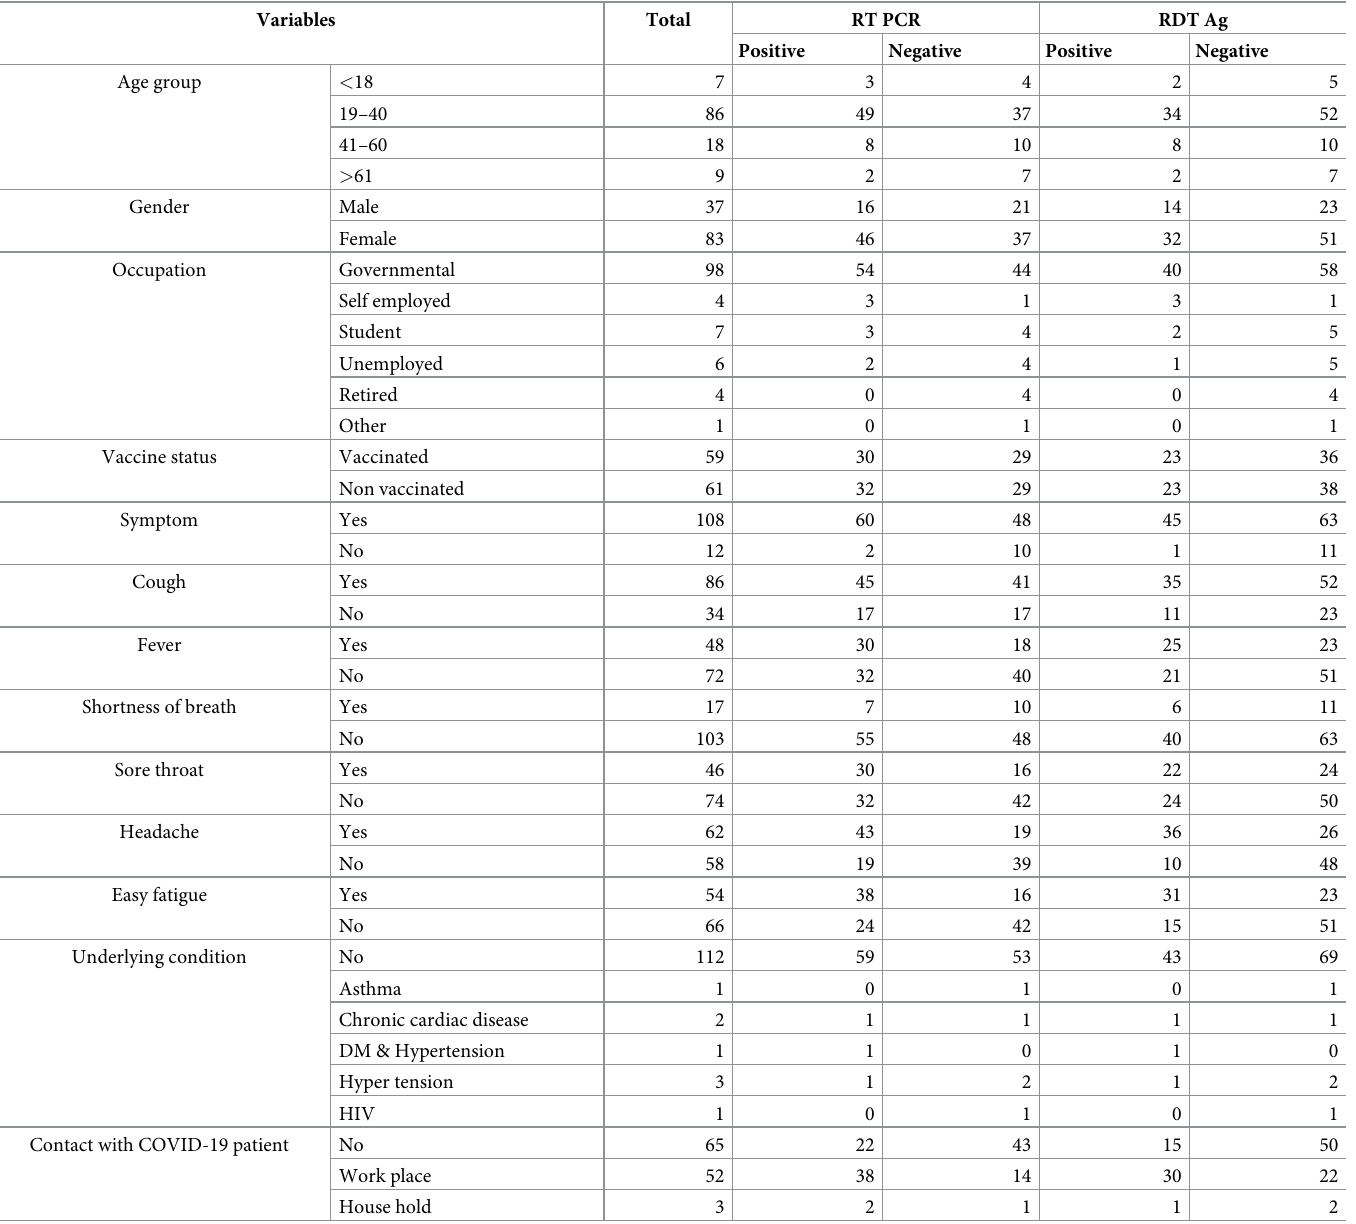
Table 1. Socio-demographic characteristics of study participants (N =